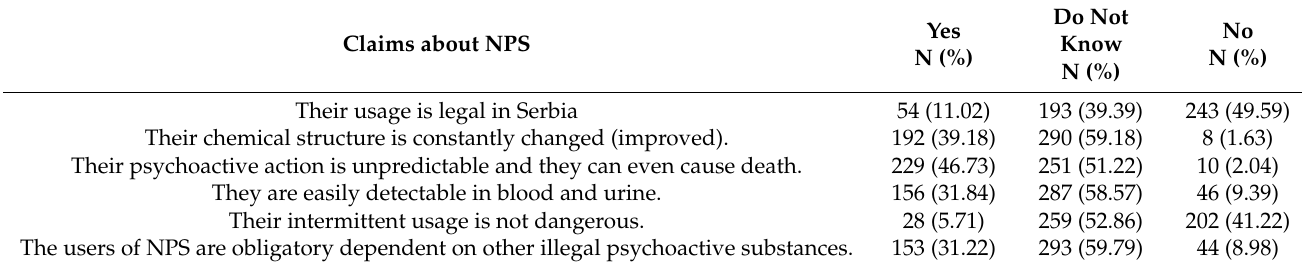
Table 6. Attitudes of future HCPs in Serbia towards